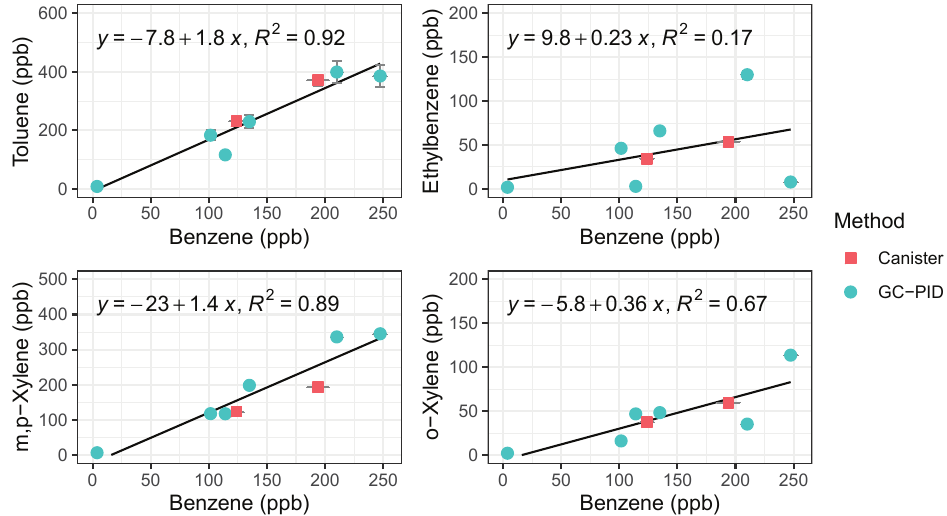
Figure 8. Regression plots of BTEX compounds from vehicle exhaust measured by the compact GC- PID instrument (blue) and samples collected in canisters (red) followed by analysis in a traditional benchtop GC. Error bars for the GC-PID are errors propagated from the calibration curve and error bars for the canister samples represent 5% precision accuracy from the benchtop